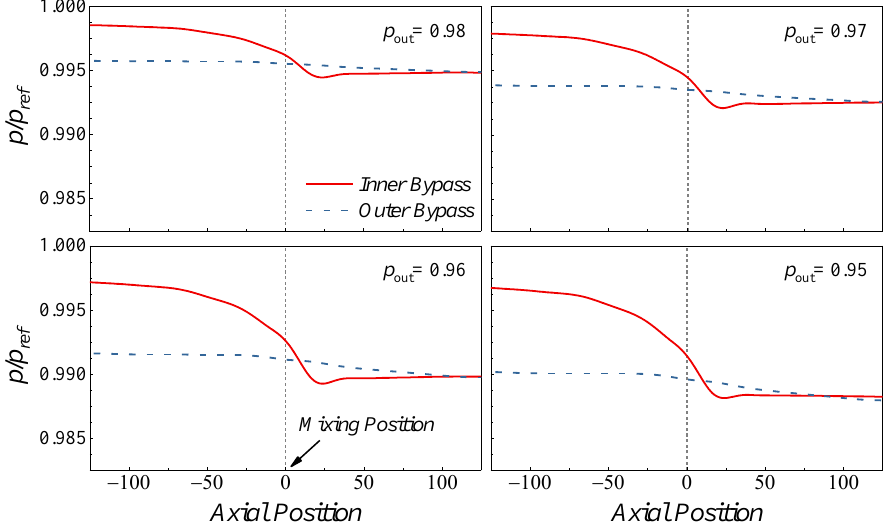
Figure 4. The distribution of static pressure along the inner bypass and the outer bypass ( α VABI = 35° and A VABI = 0.4).